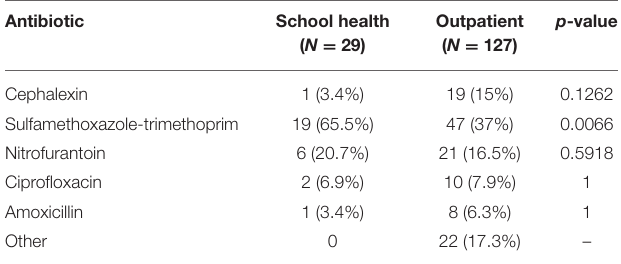
TABLE 2 | Empiric antibiotic choice, by outpatient site, n (%).